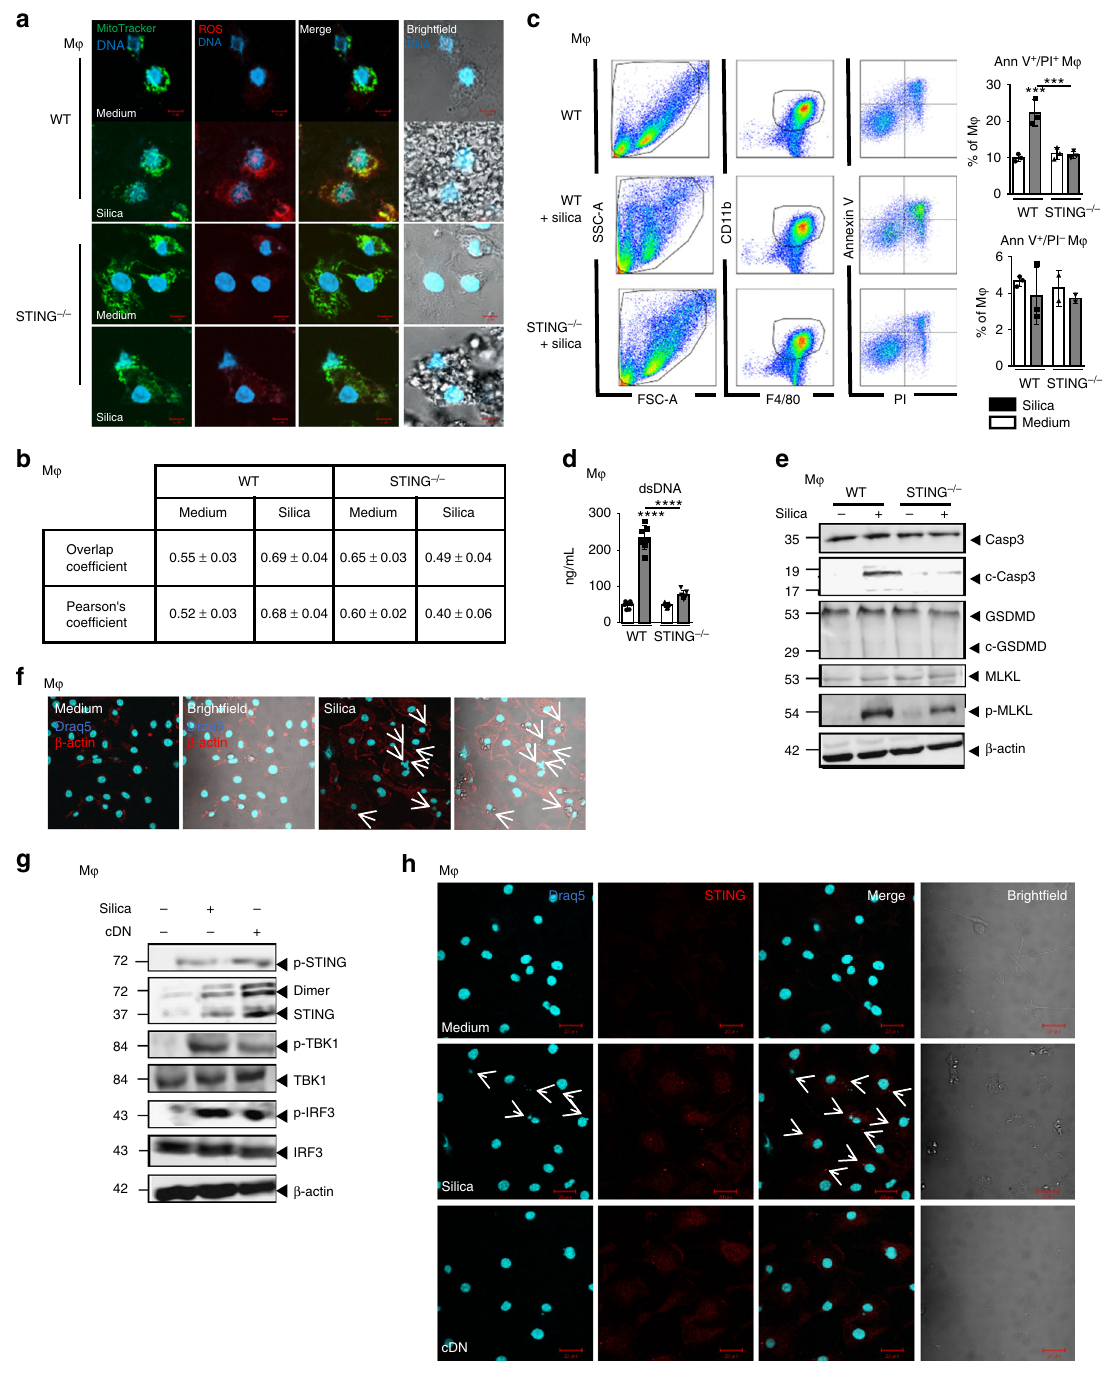
Fig. 5 Silica induces macrophage mitochondrial stress and necrosis, dsDNA leakage, and STING pathway activation. a , b WT and STING − / − bone marrow- derived macrophages were unstimulated or stimulated with silica (250 µ g/mL) for 18 h. a Bright fi eld confocal microscopy showing intracellular silica microparticles and MitoTracker (green) labeled mitochondria co-localizing with superoxide production detected by MitoSOX staining (red). Images are representative of fi ve slides from n = 3 cell cultures. Bars, 5 µ m. b Colocalization analysis of MitoTracker versus MitoSOX staining from the slides shown